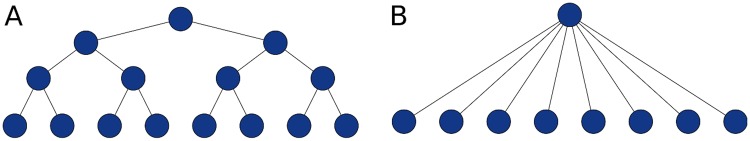
Idealized phylogenetic tree topologies available with CCMgen.CCMgen can generate multiple sequence alignments (MSAs) based on a Markov random field (MRF) model and a phylogenetic tree supplied either as Newick file or as one of the two shown, idealized topologies: A binary tree and B star-shaped tree.